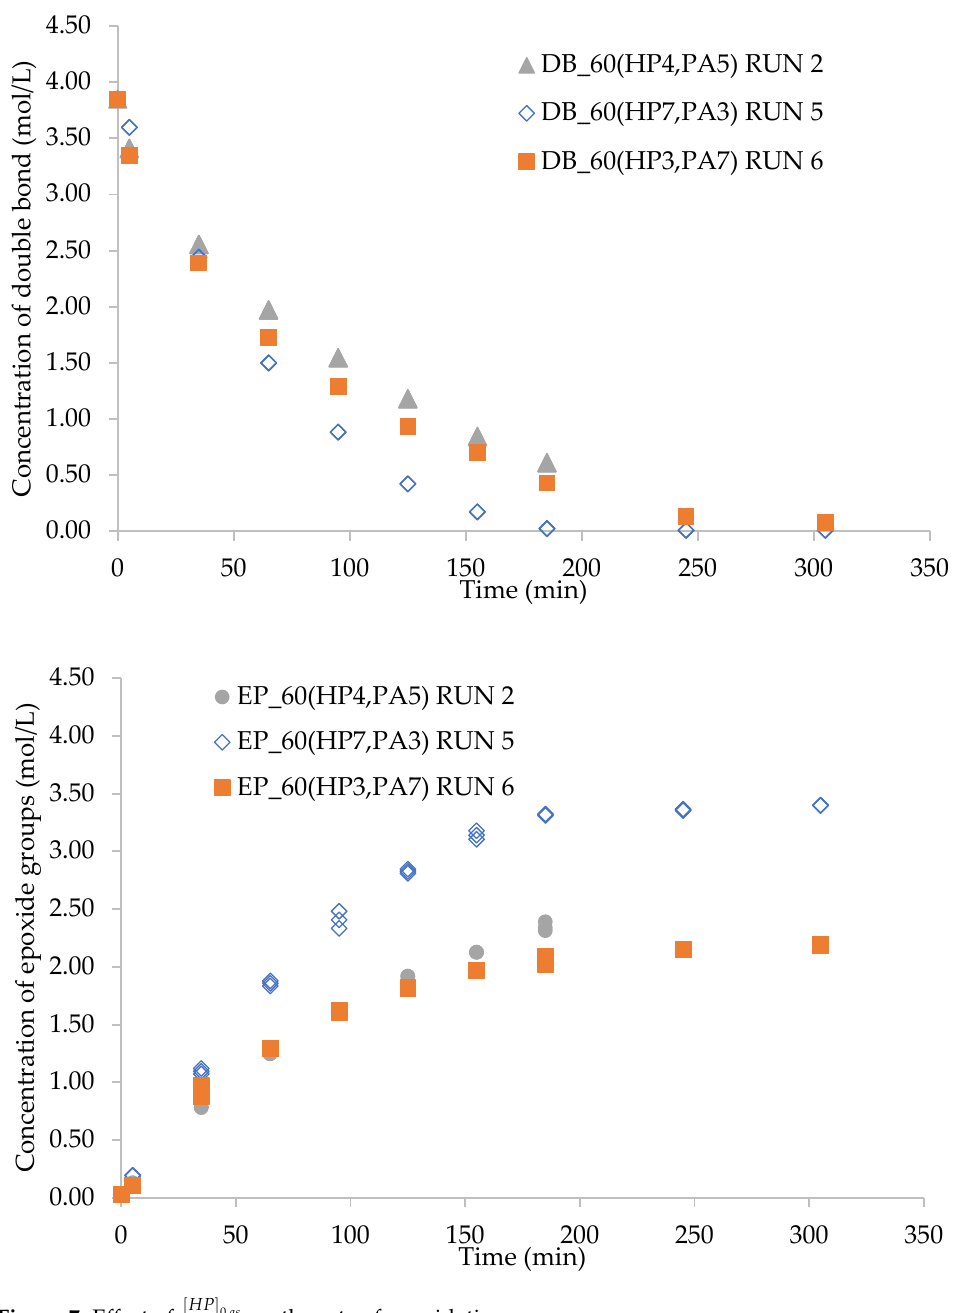
Figure 7. Effect of